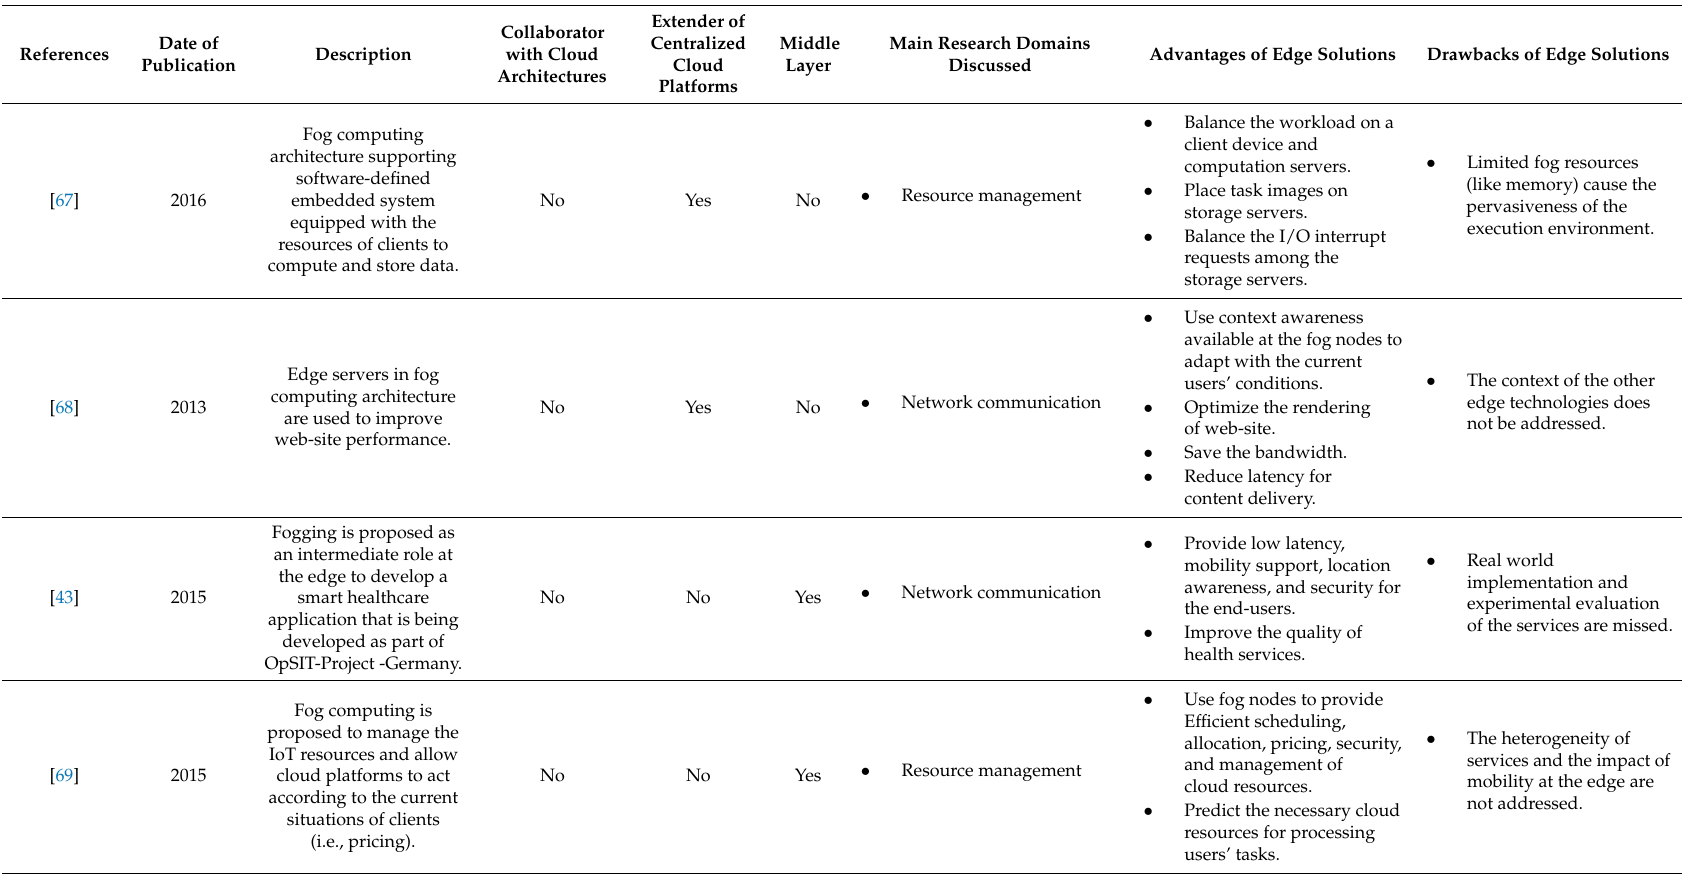
Table 3. An overview of edge computing approaches and research